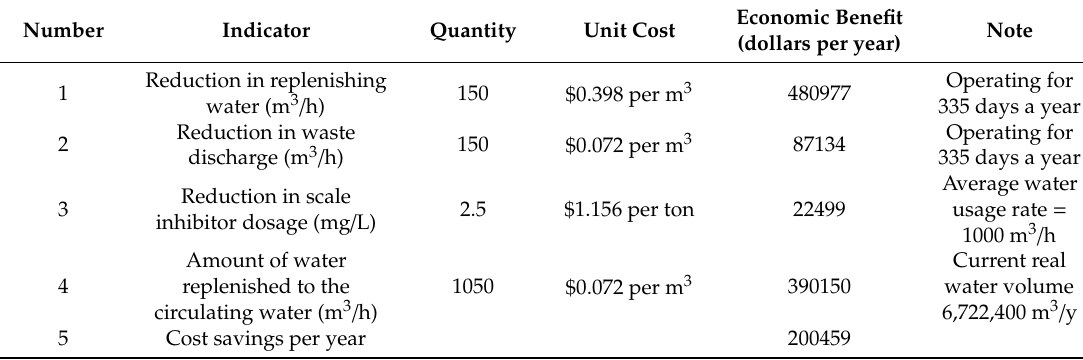
Table 6. Evaluation of the economic benefits (US